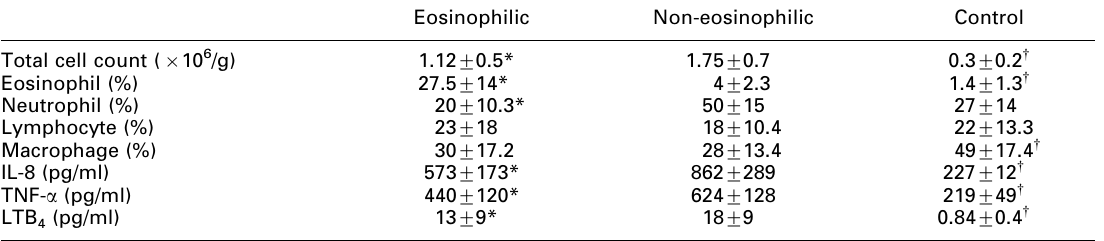
Table 2. Comparison of baseline induced sputum cell counts and inflammatory markers in asthmatics and controls